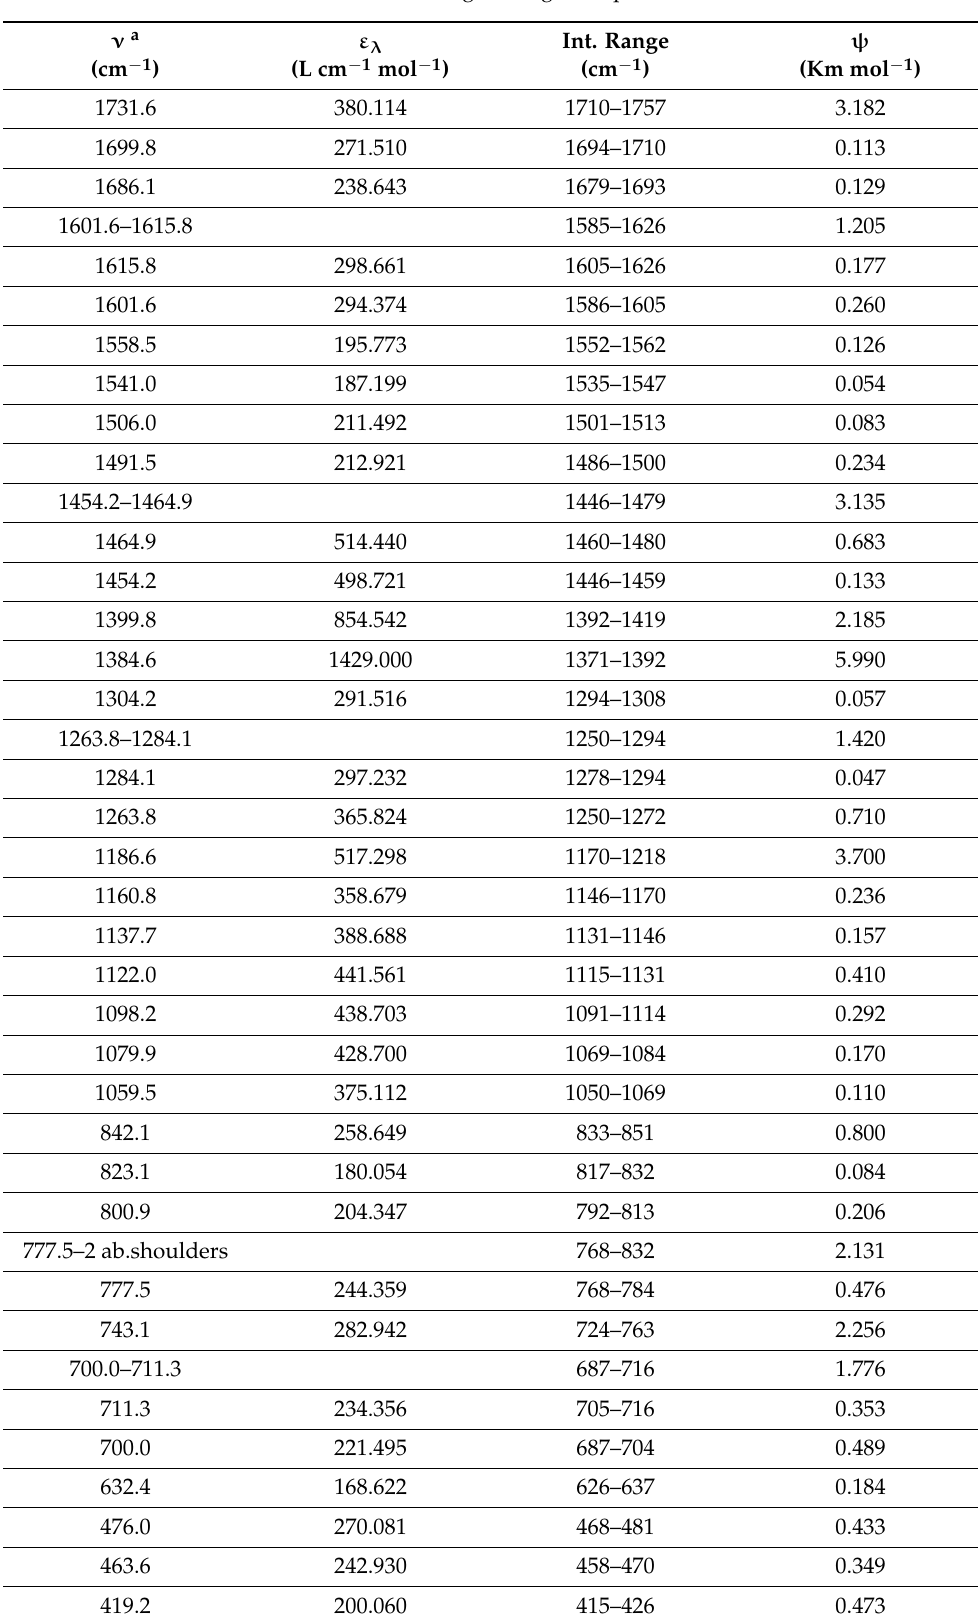
Table 1. The molar extinction coefficients and the integrated molar extinction coefficients in the appropriate integration range of separated IR absorption maxima and shoulders of C 84 -D 2 :22, as well as of several convoluted maxima with neighboring absorption shoulders of this